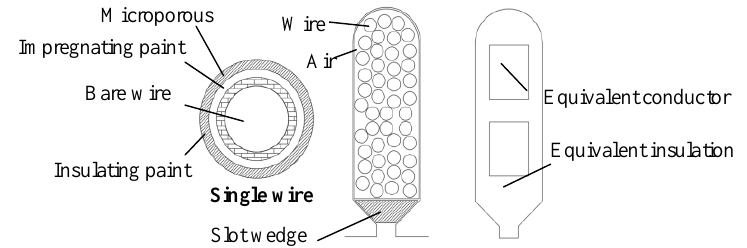
Figure 25. Equivalent winding model.